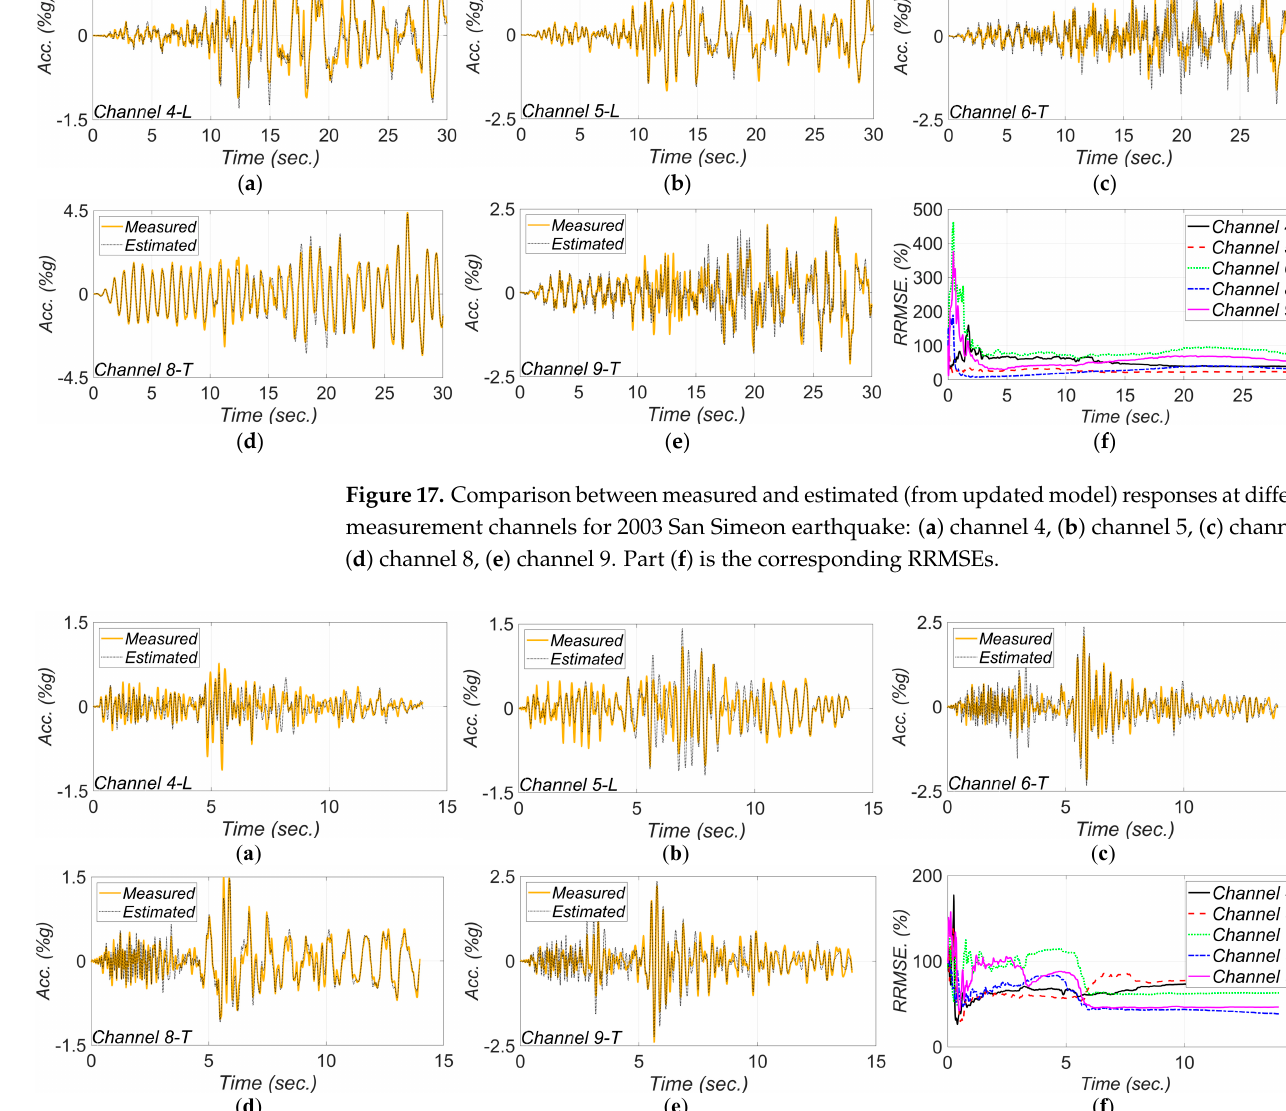
Figure 19. Comparison between measured and estimated (from updated model) responses at different measurement channels for 2013 IslaVista earthquake: ( a ) channel 4, ( b ) channel 5, ( c ) channel 6, ( d ) channel 8, ( e ) channel 9. Part ( f ) is the corresponding RRMSEs. ( a )